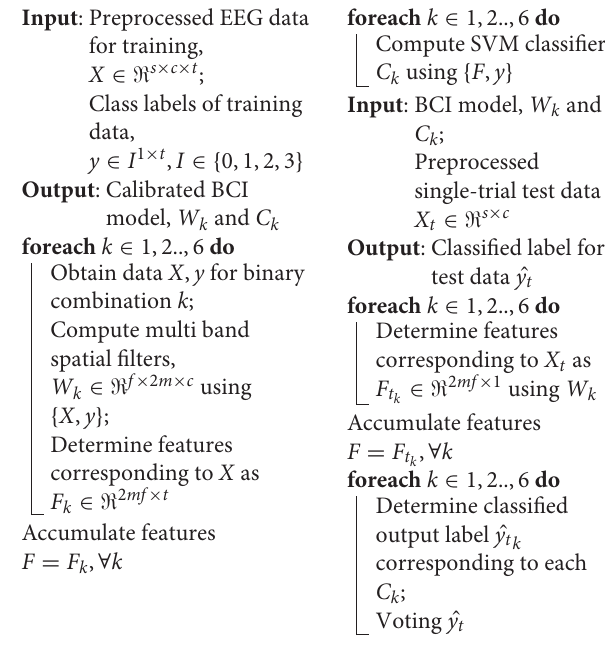
Algorithm 1: Calibration and